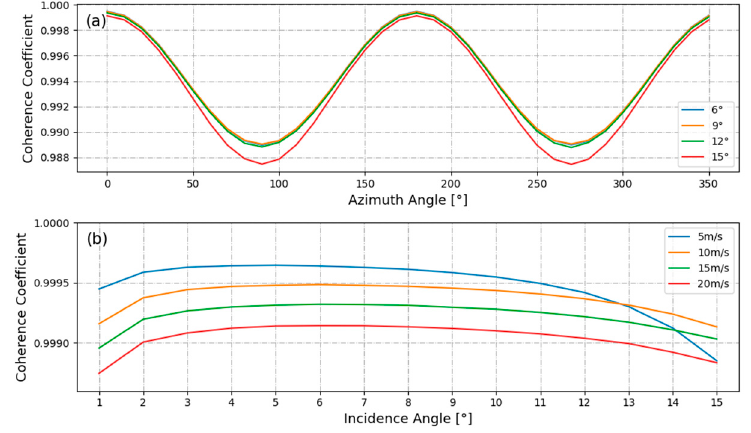
Figure 7. ( a ) incidence angle 6 ◦ , 9 ◦ , 12 ◦ , and 15 ◦ , 10 m/s wind speed, swell wavelength 150 m, wave height 1 m, wind direction and swell direction are 0 ◦ , and the pulse pair coherence coefficient with azimuth angle, ( b ) 5, 10, 15, and 20 m/s wind speed, radar azimuth, wind direction, swell direction are 0 ◦ , and different radar incidence angle of the pulse pair coherence.